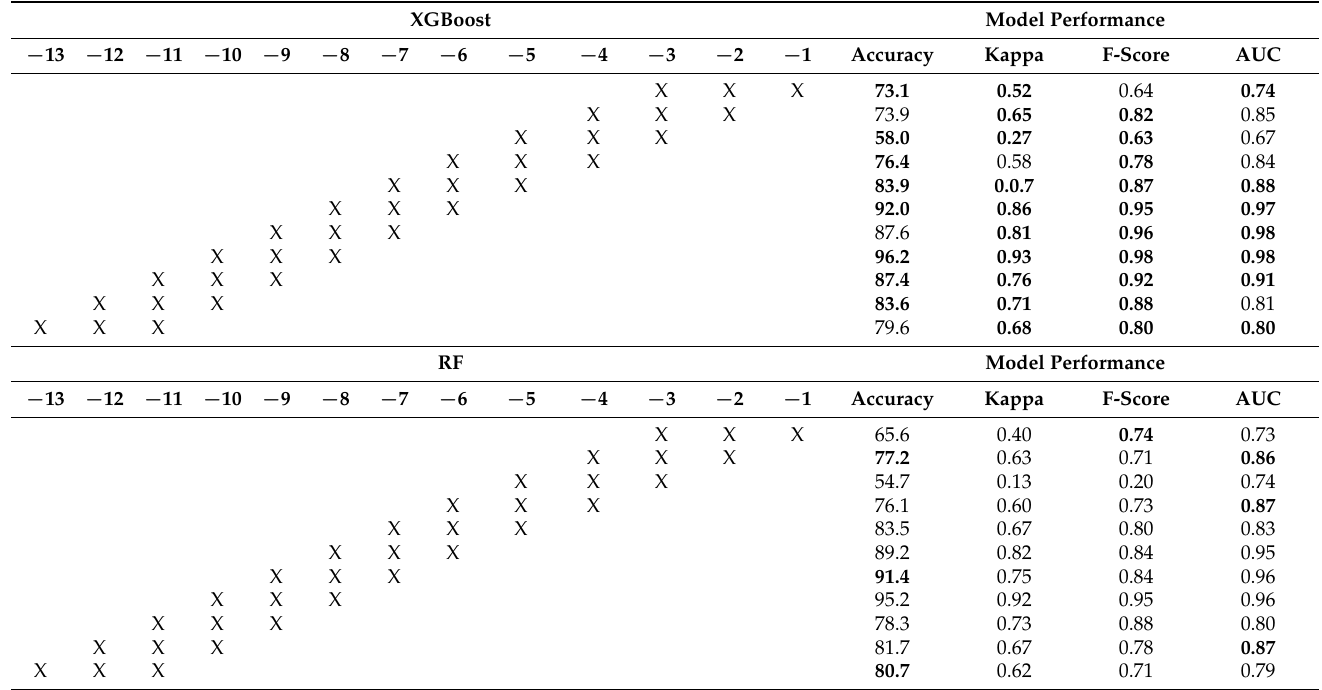
Table 4. Comparison between the performance of 3 consecutive day models using XGBoost, RF, and SVM. The best metrics are face